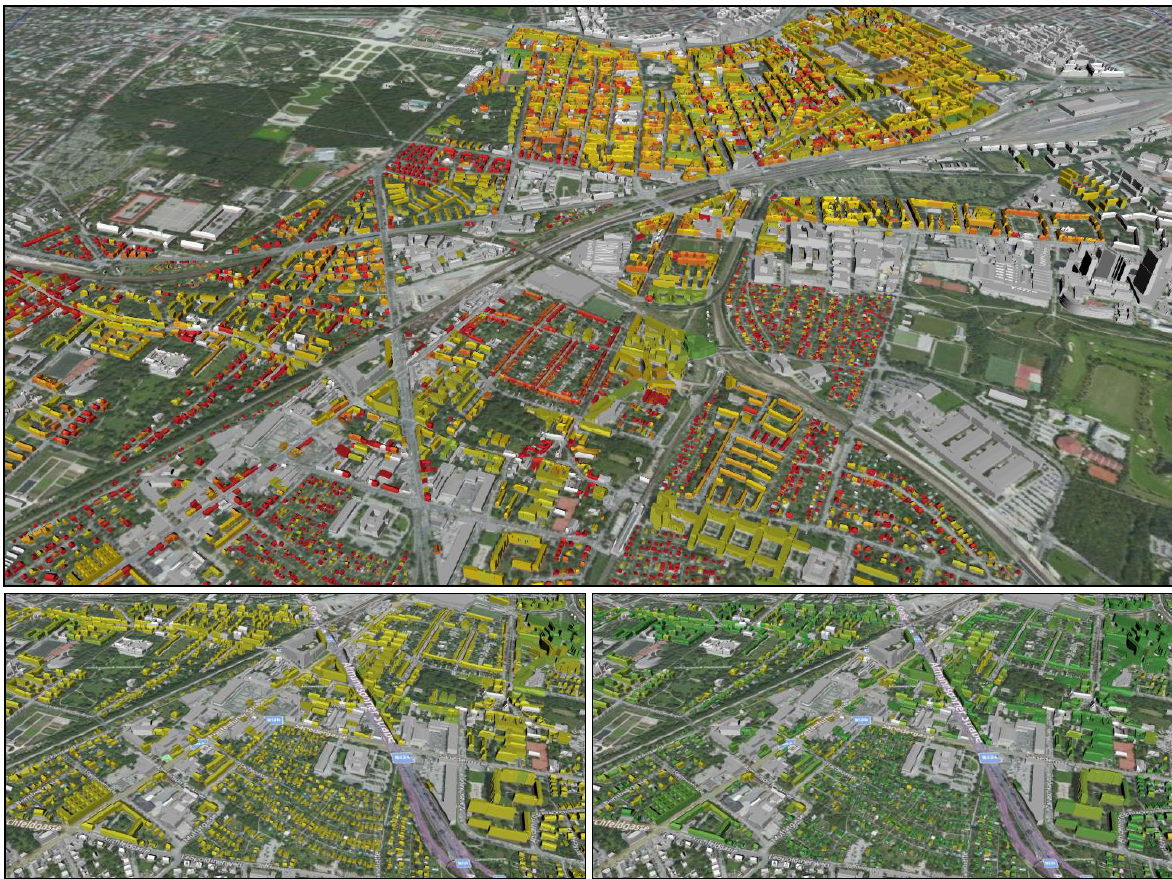
Figure 5. [Top] 3D visualisation of the energy performance class (in terms of annual area-specific primary energy demand) of all residential buildings in the 12 th district of Vienna (baseline scenario). The colours correspond to the classes provided for in the Guideline 6 of the Austrian Institute of Construction Engineering. Buildings in grey are not residential. [Bottom] Detail view of area- specific primary energy demand in two refurbishment scenarios. Left: Scenario 1 – thermal insulation of the building envelope. Right: Scenario 2 – thermal insulation of the building envelope in combination with roof-mounted photovoltaics